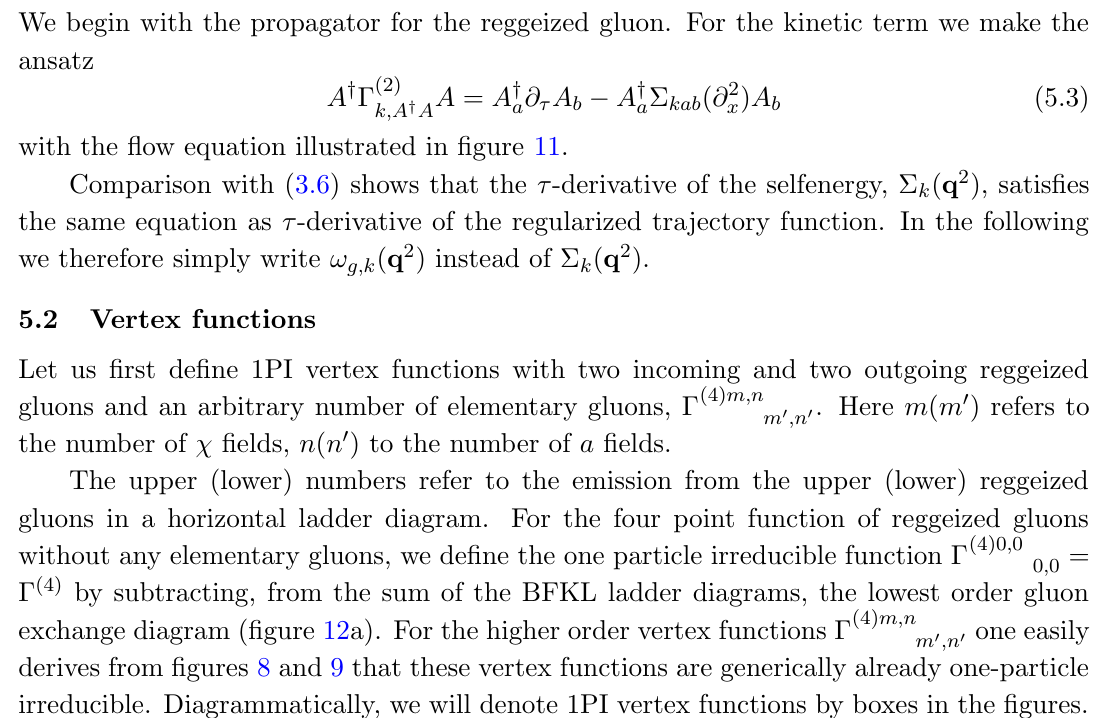
Figure 11 . Flow equation for the selfenergy of the reggeized